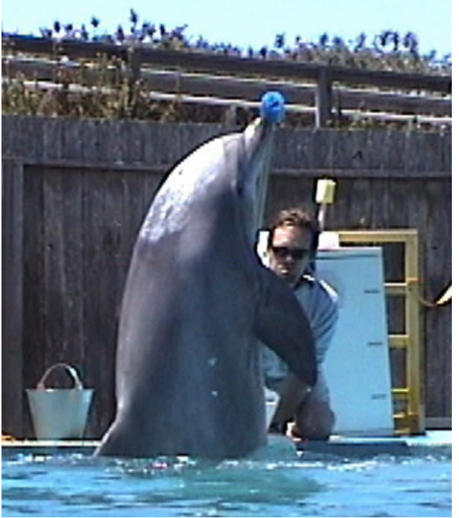
Figure 1. Dolphin performing tail stand. The dolphin was trained to target a blue float and rise to a height out of the water under trainer